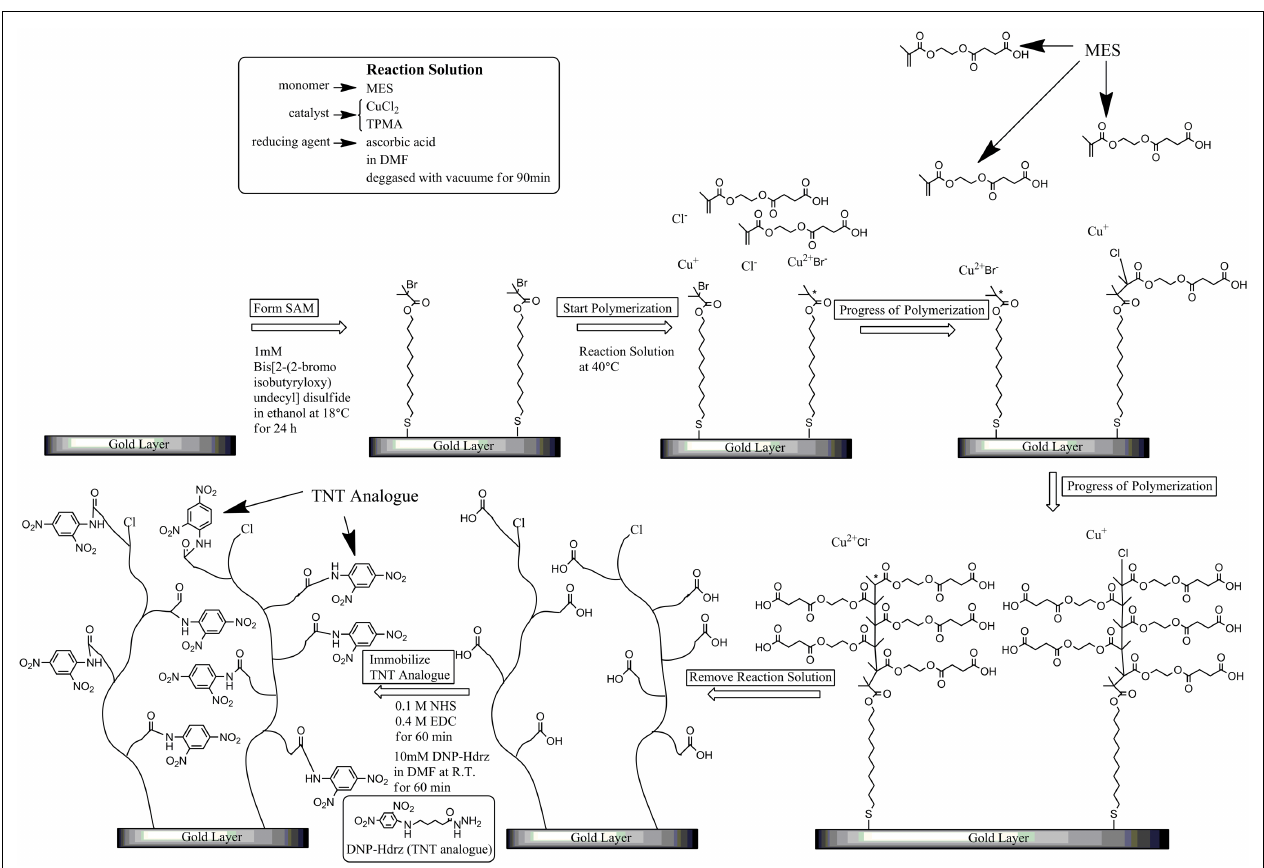
FIGURE 1 | Fabrication procedure of polymer-based sensor surface by SI-(AGET)ATRP